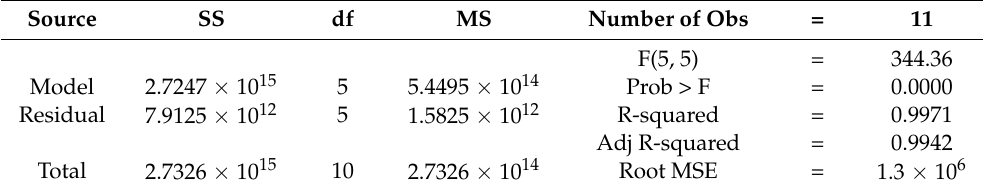
Table 10. Multiple linear regression analysis.